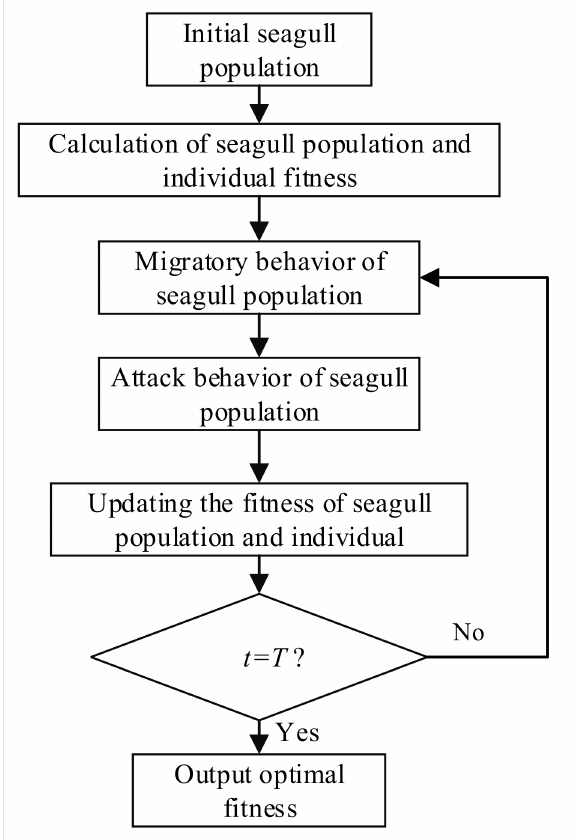
Figure 1. SOA optimization